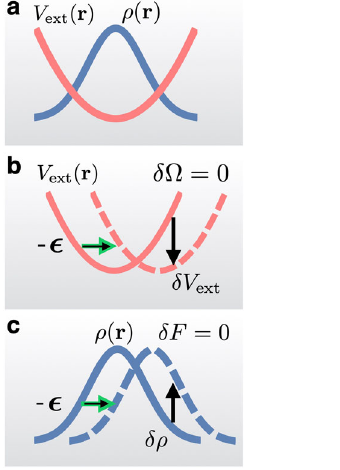
Fig. 2 Illustrations of the effects induced by shifting in equilibrium. a In the presence of external potential V ext ( r ), the system develops an inhomogeneous density pro fi le ρ ( r ), where r denotes the position coordinate. b Shifting the external potential by a displacement vector − ϵ (green arrow) induces a local change in external potential δ V ext ( r ) (black arrow) between the original (solid line) and the shifted external potential (dashed line); the grand potential is invariant, δ Ω = 0. c The displaced density pro fi le (dashed line) implies a local change δρ ( r ) (black arrow) in comparison to the initial density pro fi le (solid line), which leaves the intrinsic free energy unchanged, δ F =